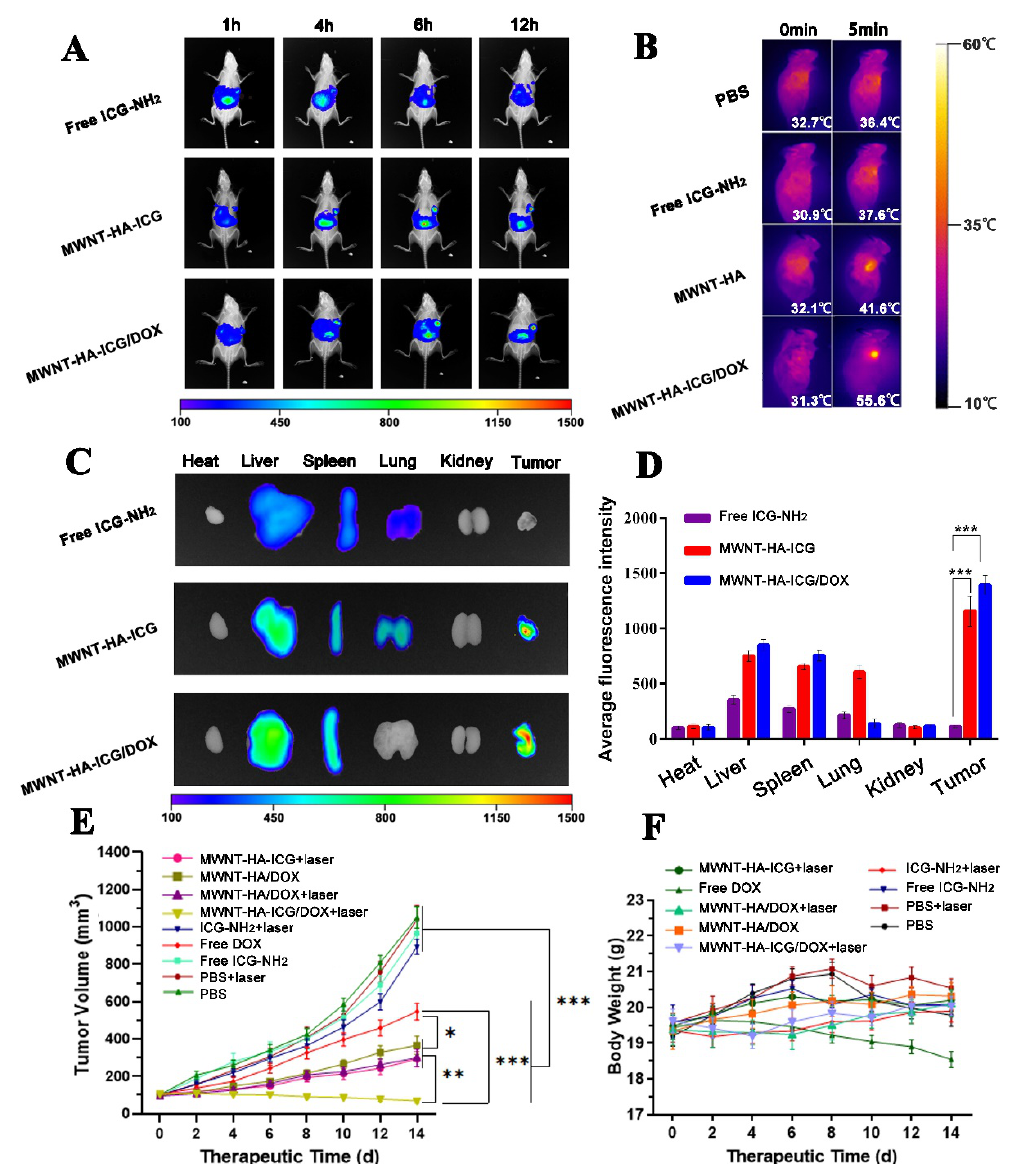
Figure 6. ( A ) Representative time-lapse in vivo imaging and biodistribution of MCF-7-tumor-bearing nude mice intravenously injected with ICG-NH 2 , MWNT-HA-ICG, and MWNT-HA-ICG/DOX. ( B ) Infrared thermographic maps of mice upon laser irradiation (808 nm, 1.0 W/cm 2 ) at 6 h after IV injection with PBS, ICG-NH 2 , MWNT-HA, and MWNT-HA-ICG/DOX. ( C ) Representative ex vivo NIR imaging of tumors and major organs excised from mice at 12 h post-injection. ( D ) Quantitative analysis of the fluorescence intensity in tumors and major organs at 12 h post-injection. ( E ) Tumor growth and ( F ) body weight curves of mice after IV administered with different formulations. Data were expressed as mean ± S.D. ( n = 3). * p < 0.05, ** p < 0.01 and *** p < 0.001.